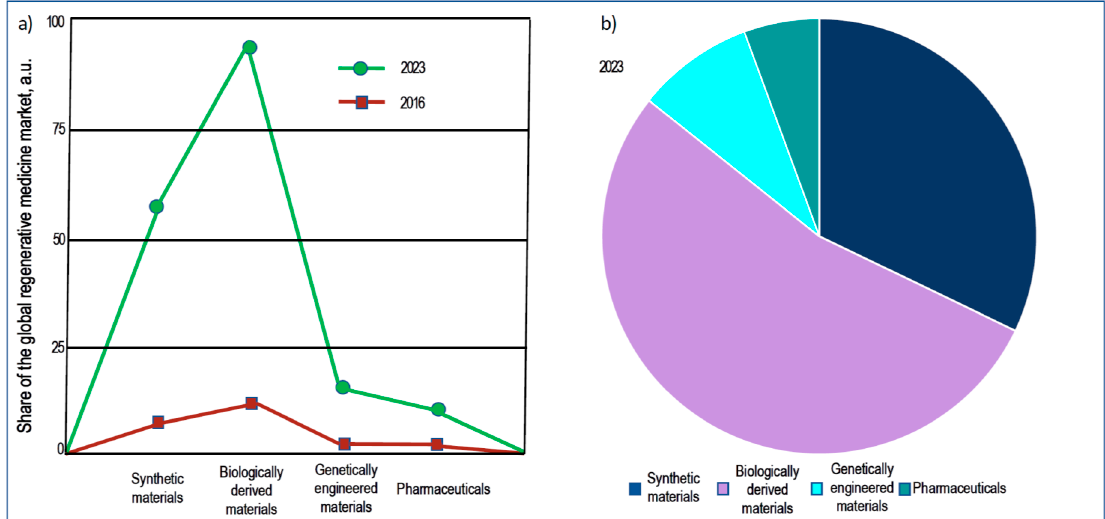
Figure 39. Scheme of forecasting the increase in the share of various groups of biomaterials used in regenerative medicine in the world in 2016–2023: ( a ) bar chart; ( b ) pie chart.